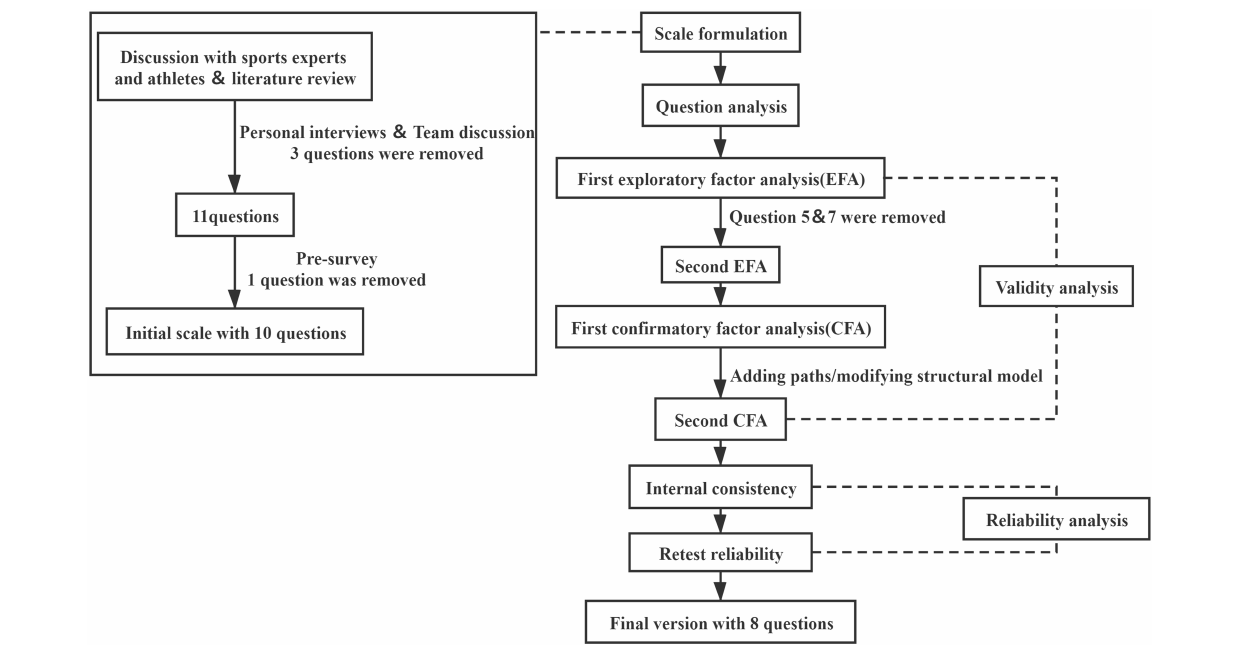
FIGURE 1 | Steps and analysis methods used in the scale